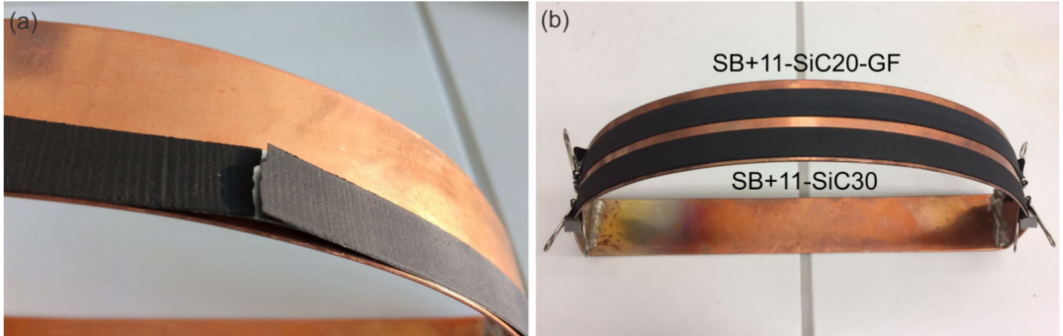
Figure 8. Results of resistance against thermal shock tests performed on 30-cm-long Hastelloy / Ag tapes covered with di ff erent thermal stabilization layers: ( a ) SB + 11-SiC20 cracked and delaminated due to thermal cycling from LN2 to RT; ( b ) SB + 11-SiC20-GF and SB + 11-SiC30 after thermal cycling from LN2 to 150 ◦ C without visible